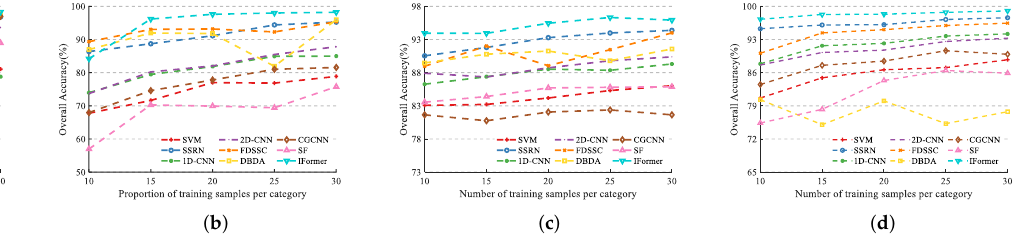
Figure 14. Performance of our proposed method and comparison methods on different datasets with different training samples. ( a ) Indian Pines dataset. ( b ) University of Pavia dataset. ( c ) Salinas dataset. ( d ) Long Kou